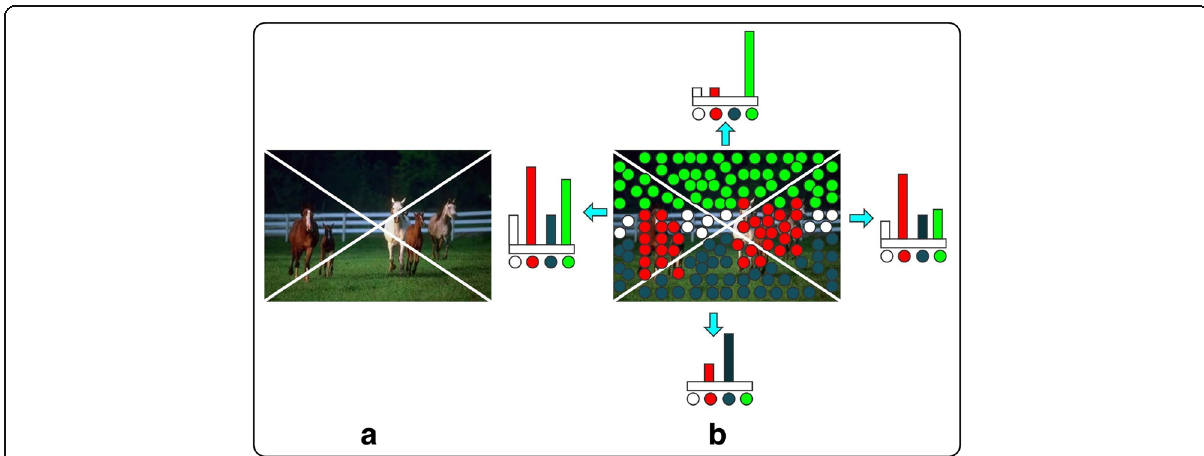
Fig. 4 Image a is chosen from the image benchmark of the Corel-1K, which presents the division into four adapted triangular areas, and image b is presenting the method for computation of spatial histograms over the four adapted triangular areas of the image [20,